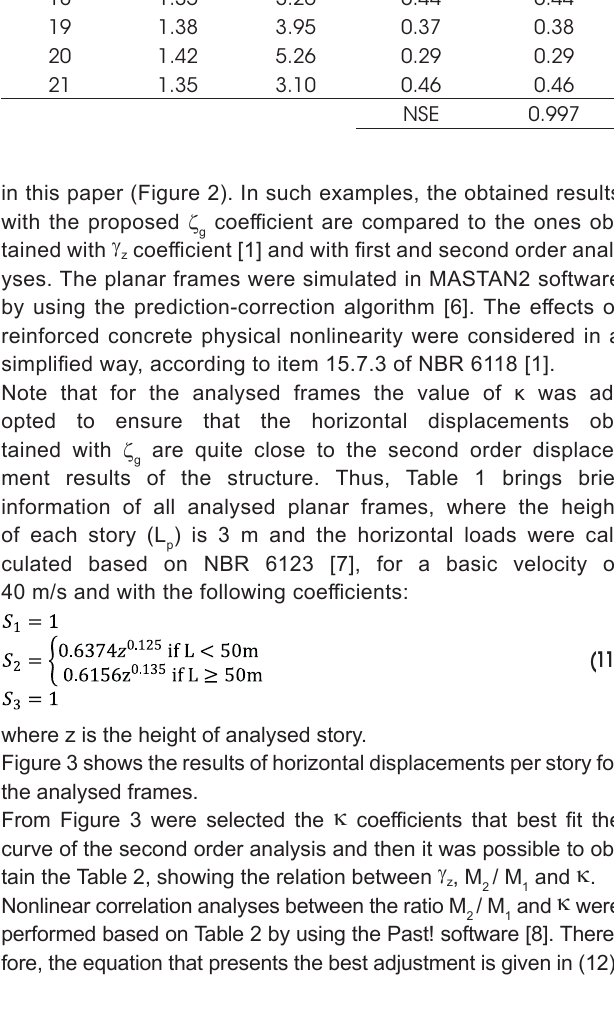
/M and κ with confidence 2 1